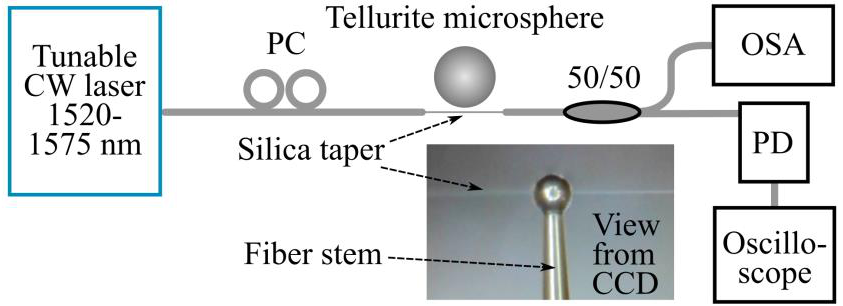
Figure 5. Simplified schematic diagram of the experimental setup. Inset: microphoto of the used tellurite microsphere and silica fiber taper.